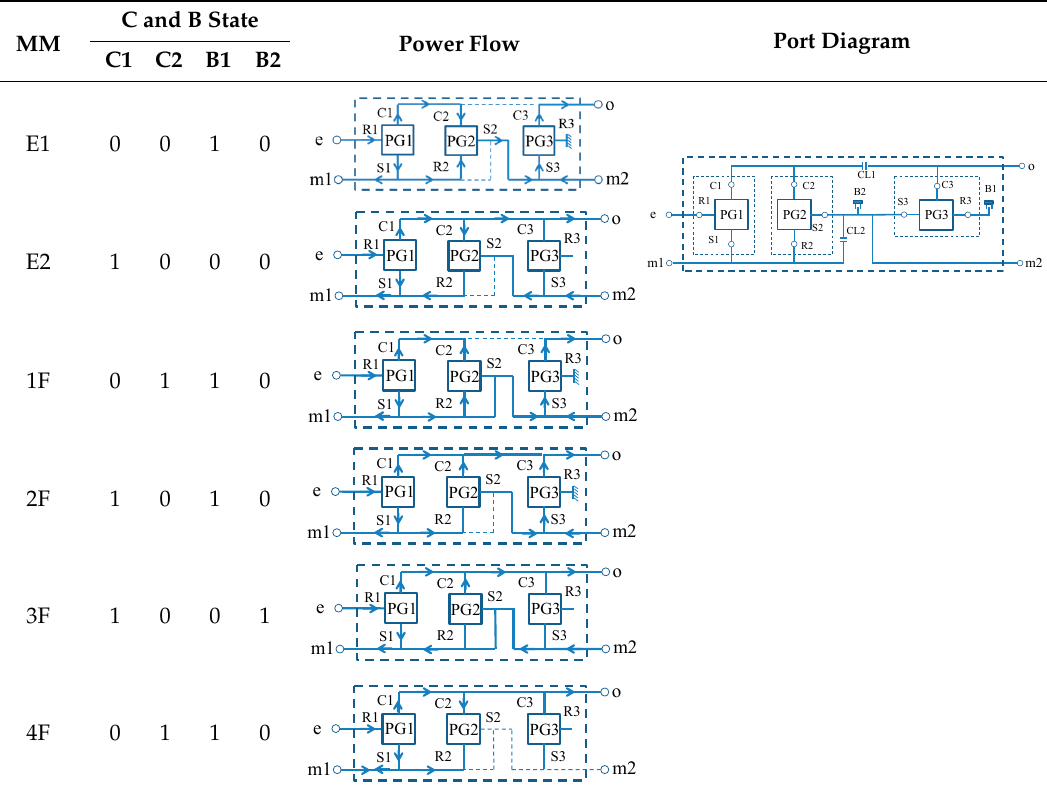
Table 5. The power flow of the main drive modes of GM AHS2 by four-port diagram.